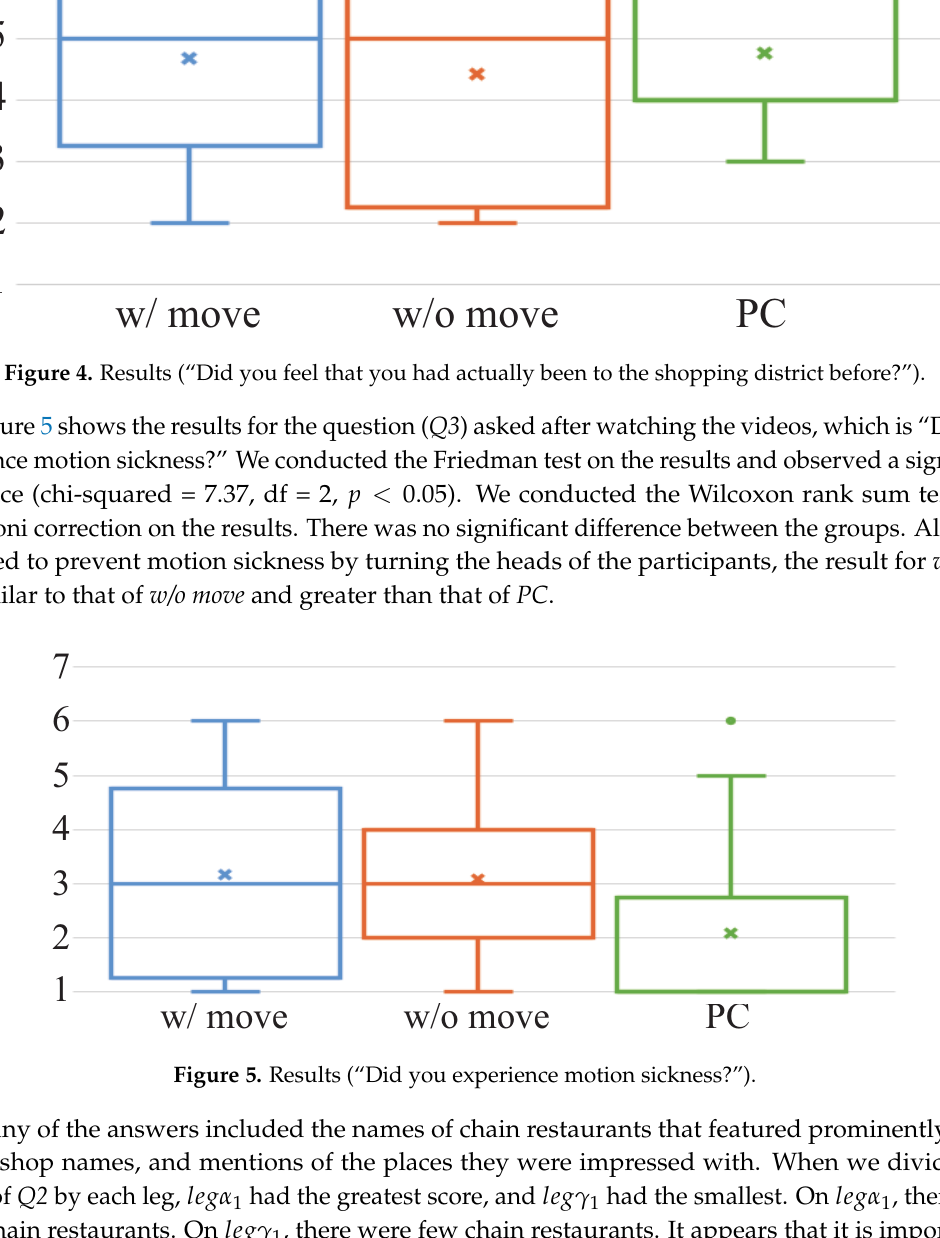
Figure 5. Results (“Did you experience motion sickness?”).